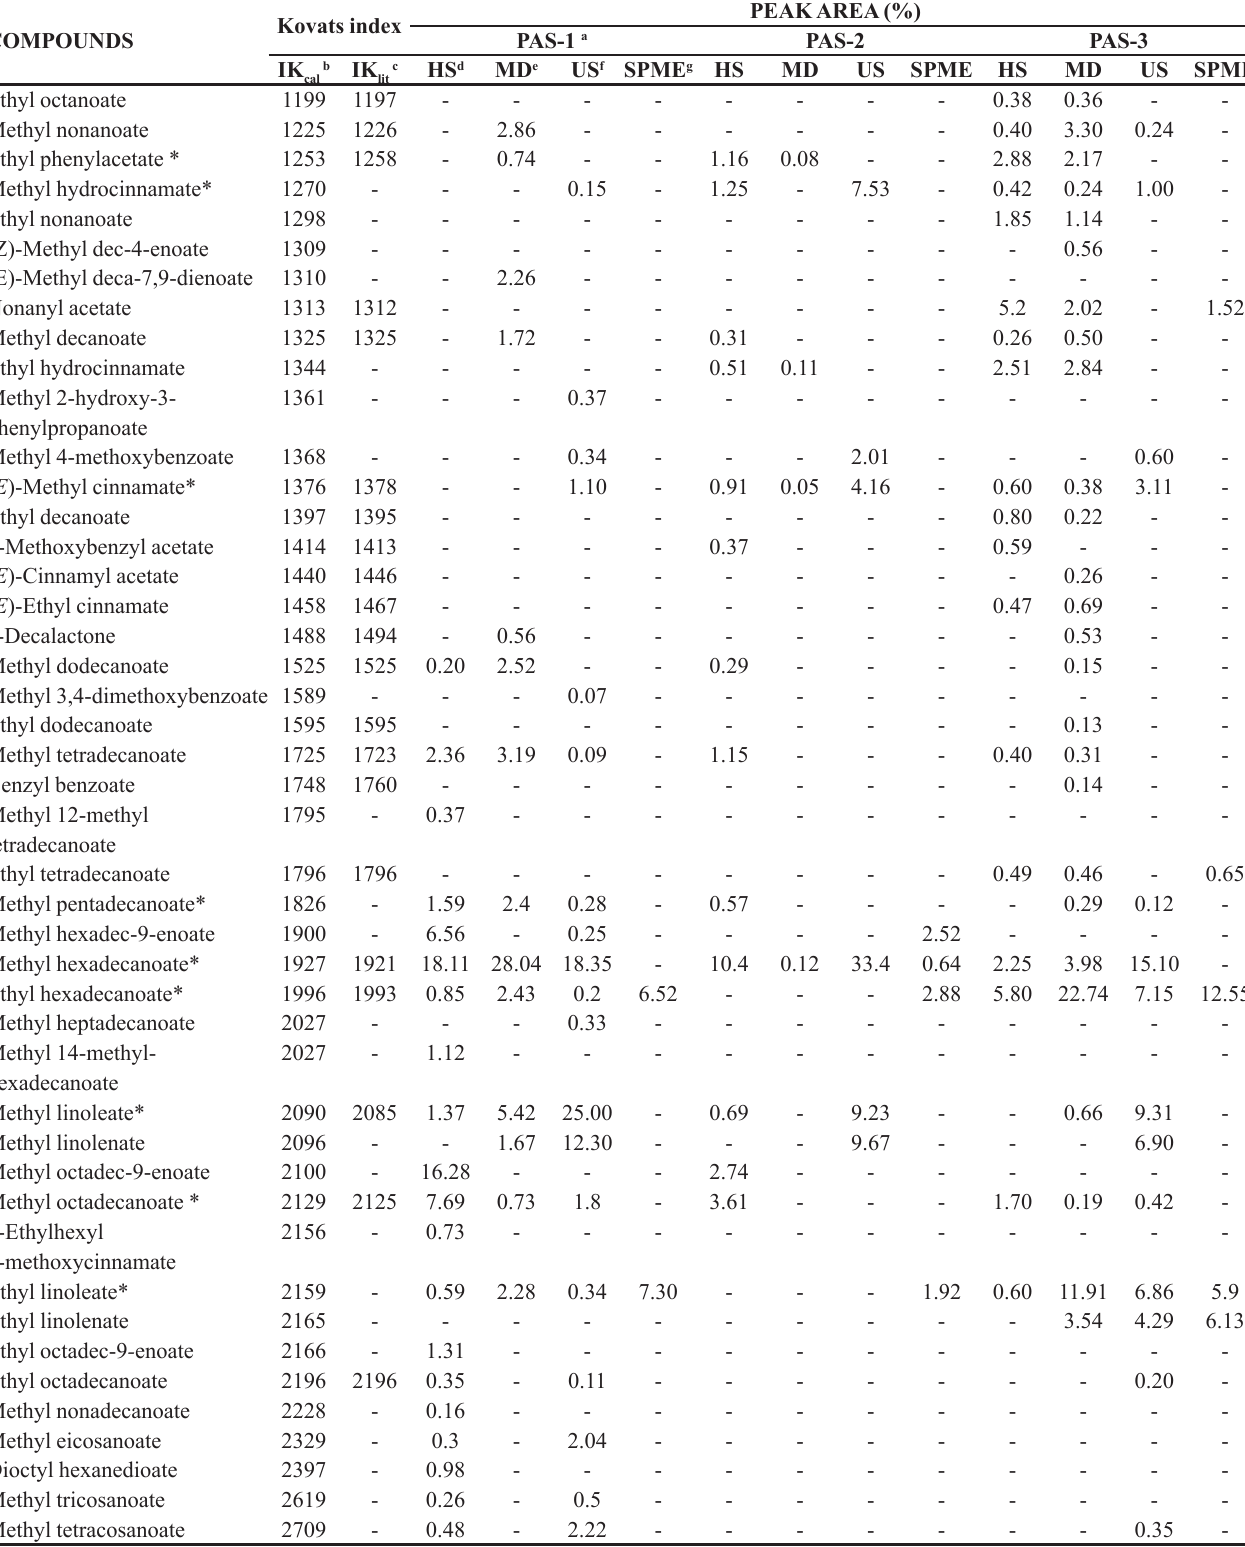
TABLE I - Chemical constituents of volatile stingless bee pollen collected in the months of December, March and July and extracted by HS, MD, US and SPME with their relative abundances